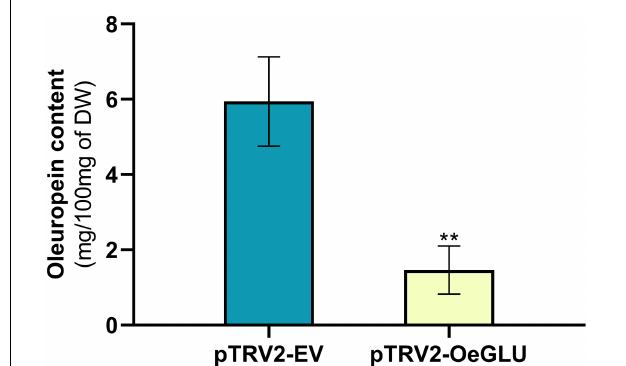
FIGURE 4 | Oleuropein content (mg) per 100 mg (dry weight) of olive leaves. Olive plantlets Agroinoculated either with pTRV2-EV ( n = 3) or with pTRV2-OeGLU ( n = 6) constructs were screened ( Supplementary Table 2 ). Mean ± SE and asterisks denote statistical significance (** P ≤ 0.01; Student’s t -test). EV, empty vector; OeGLU, oleuropein β